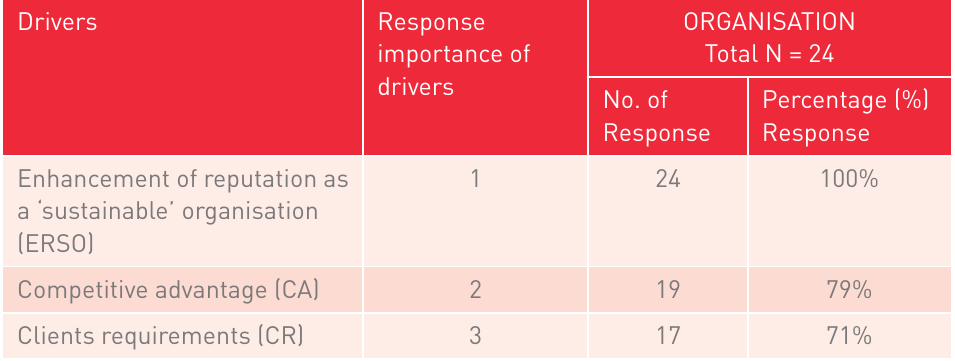
Semi-structured interview results of the socio-economic